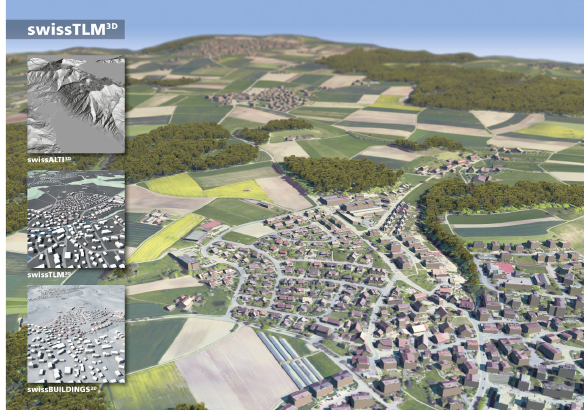
Figure 6. 3D topographic landscape model created by